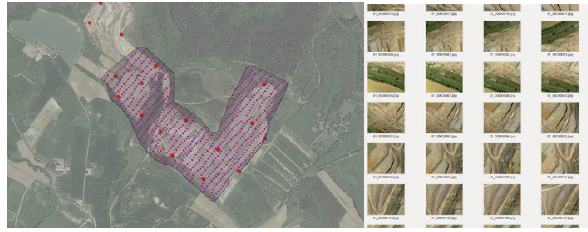
Figure 2. Left : the fight path (purple dots) and GCPs distribution (red dots) of UX11 and senseFly dataset. Right : some images of the scene extracted from the UX11 dataset.